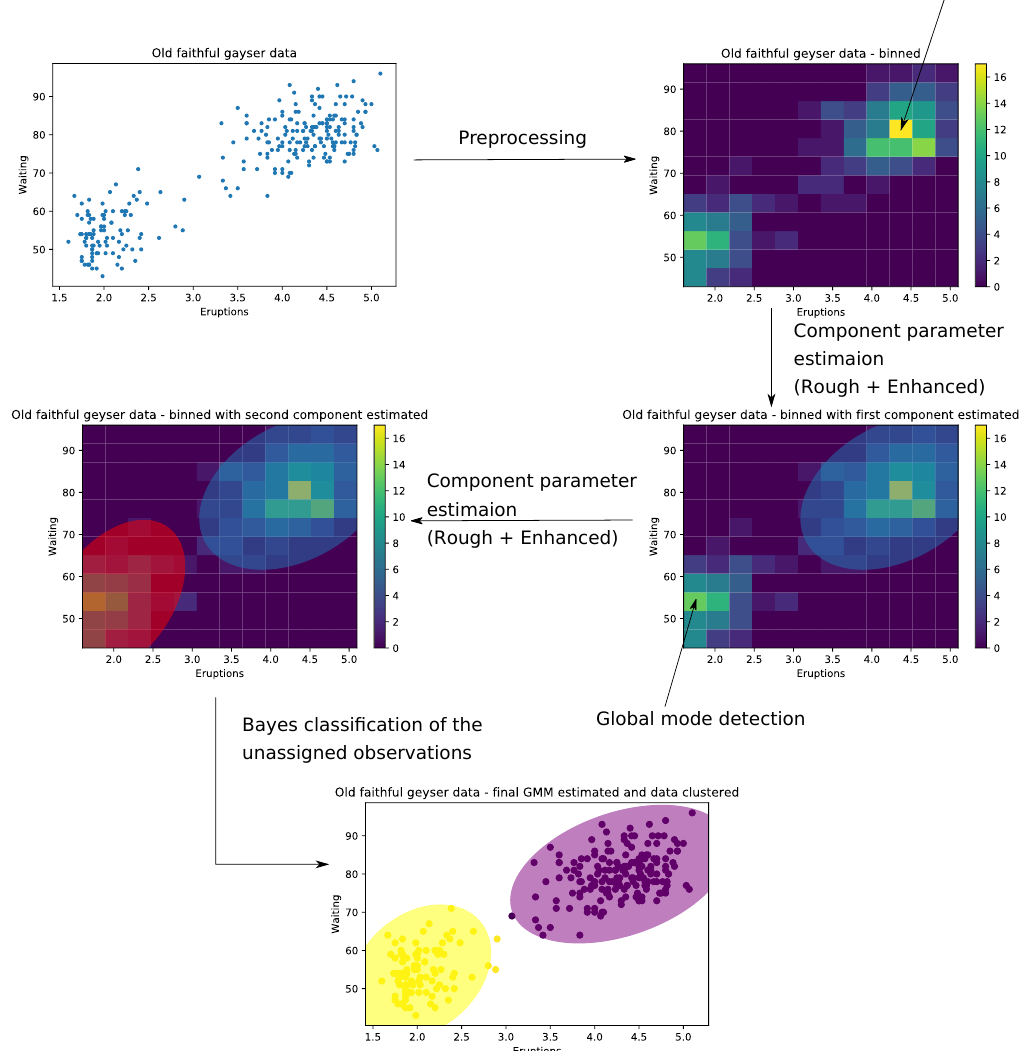
Figure 1. Illustration of the REBMIX algorithm on Old Faithful geyser